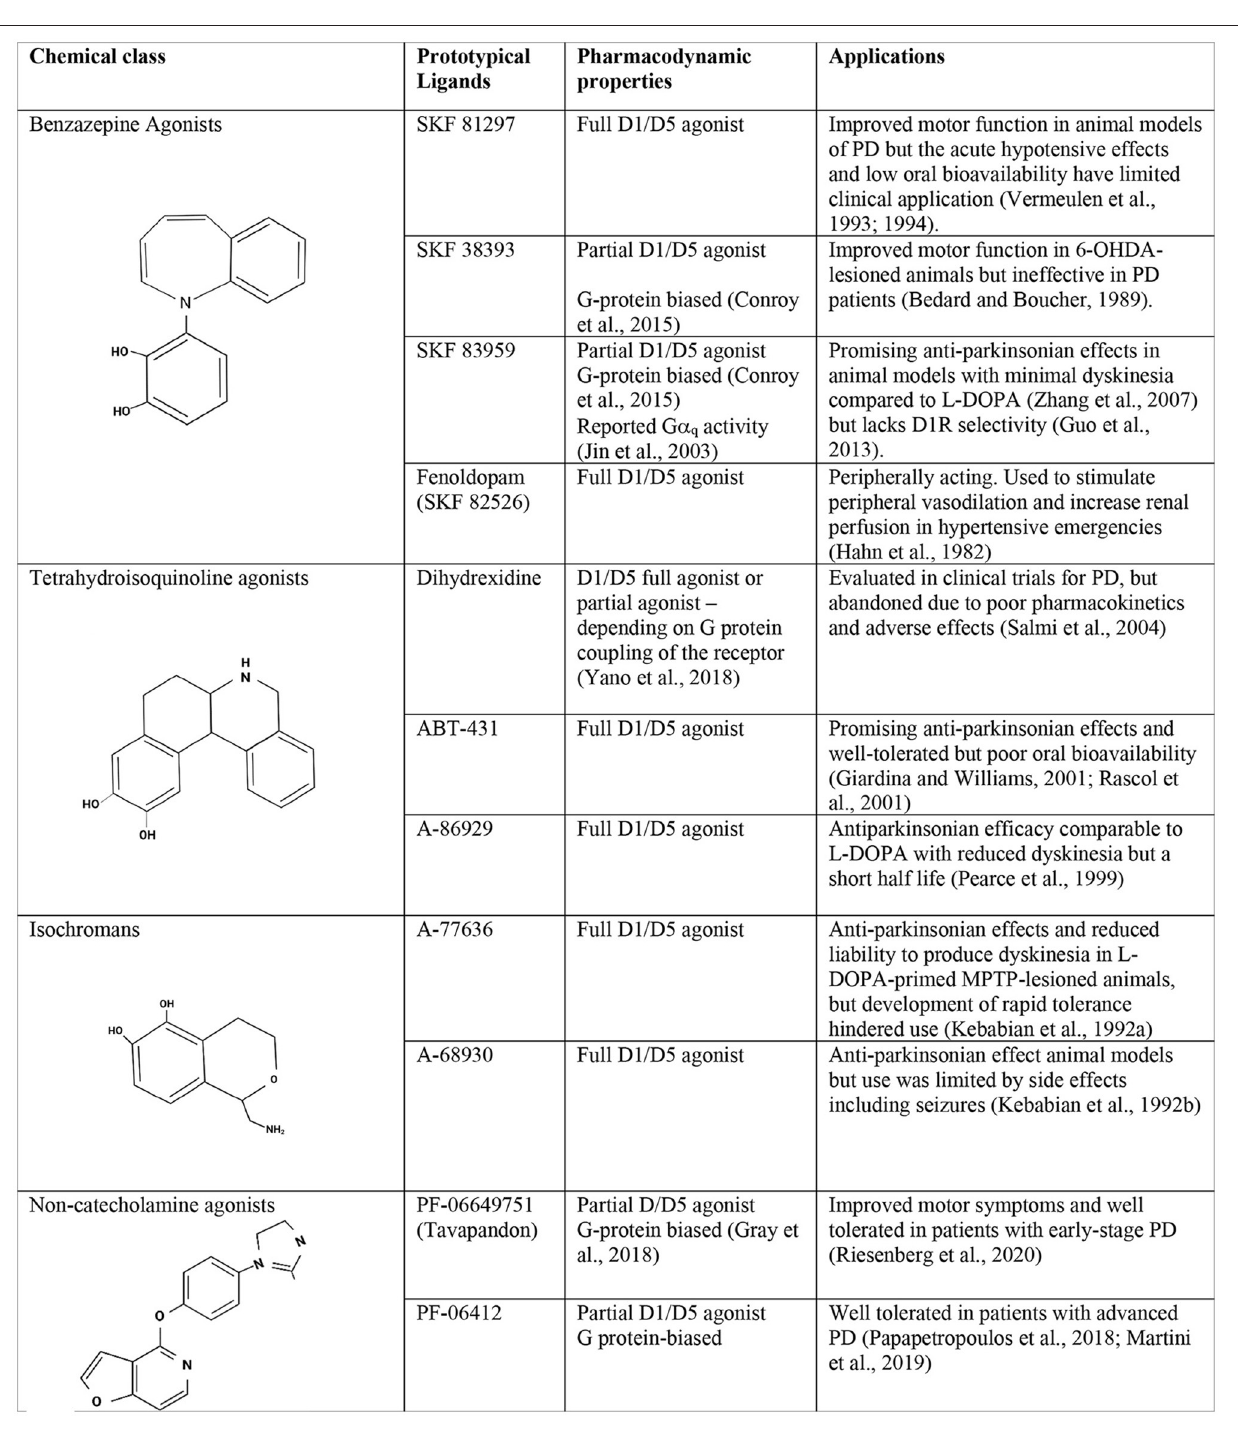
of reducing the development of drug tolerance, by avoiding receptor